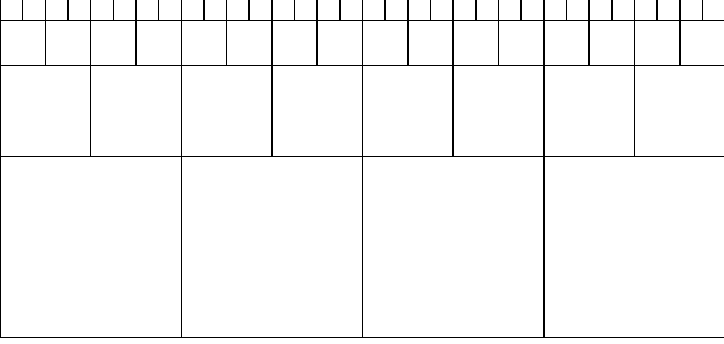
Fig. 13: Example of B¨or¨oczky